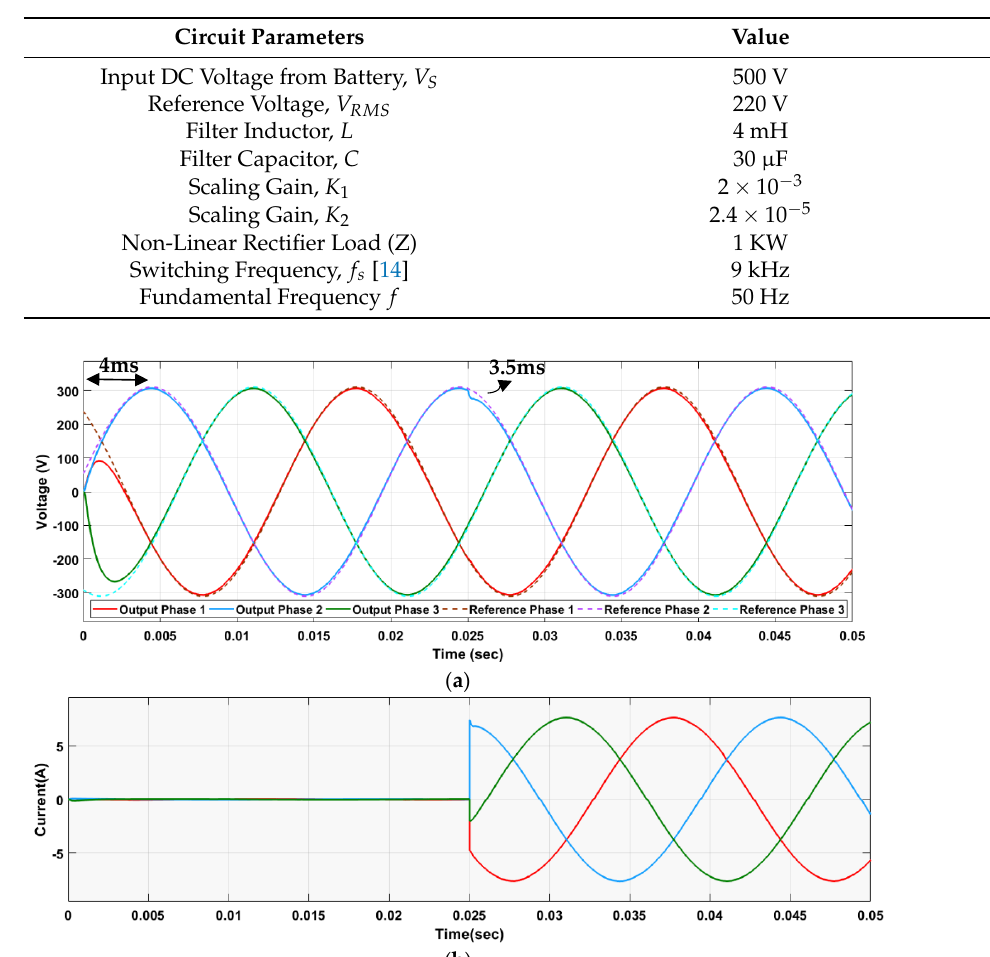
Figure 6. ( a ) PRERL [27], output voltage-reference tracking trajectory and voltage regulation. ( b ) PRERL [27], load current-step response under extreme load